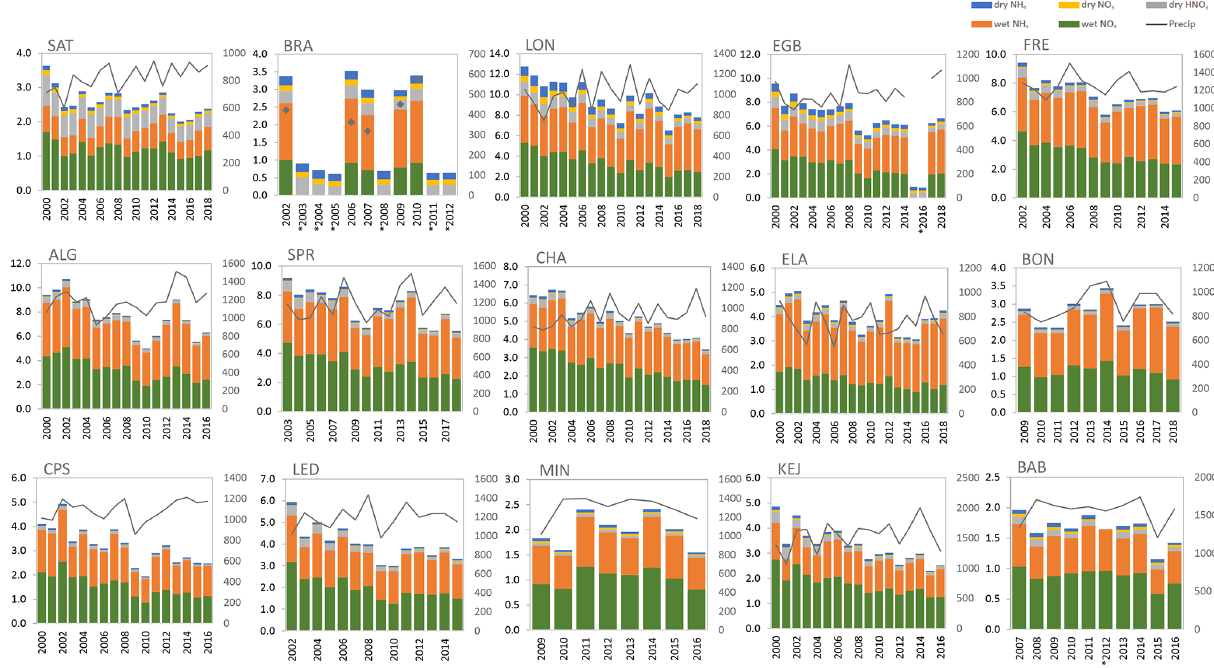
Figure 9. Long-term annual trends in total (dry + wet) deposition of nitrogen at CAPMoN sites, 2000–2018. Total deposition (kgNha − 1 yr − 1 , primary y axis); precipitation (mmyr − 1 , secondary y axis); ∗ indicates dry or wet deposition data were not available because data completeness criteria was not met.